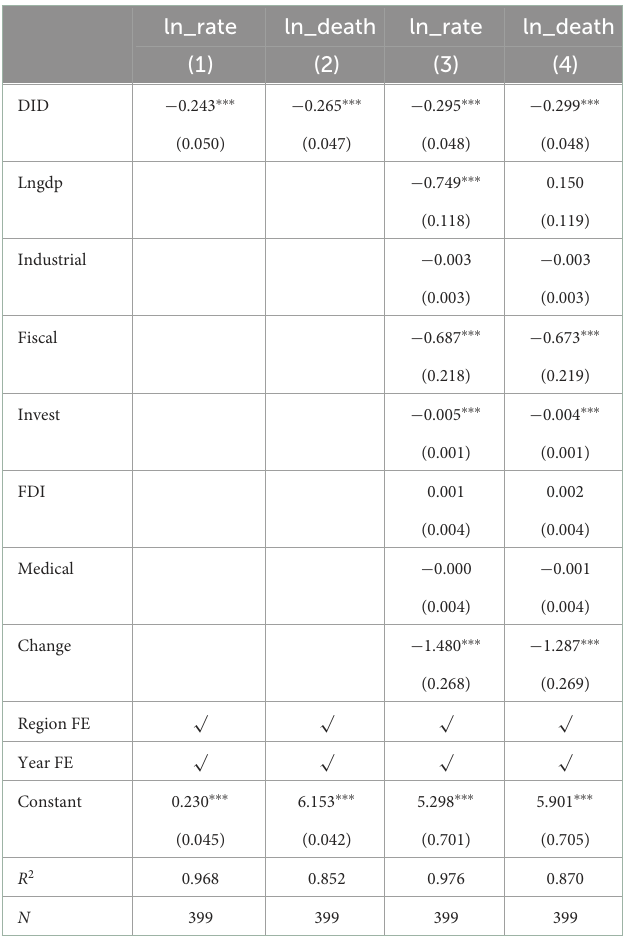
TABLE 2 Regress results of “Broadband China” policy pilot and occupational